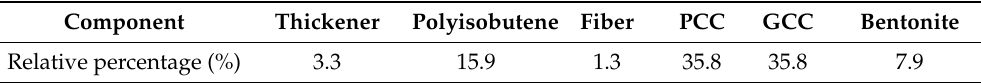
Table 3. Ratio of other component in sealing